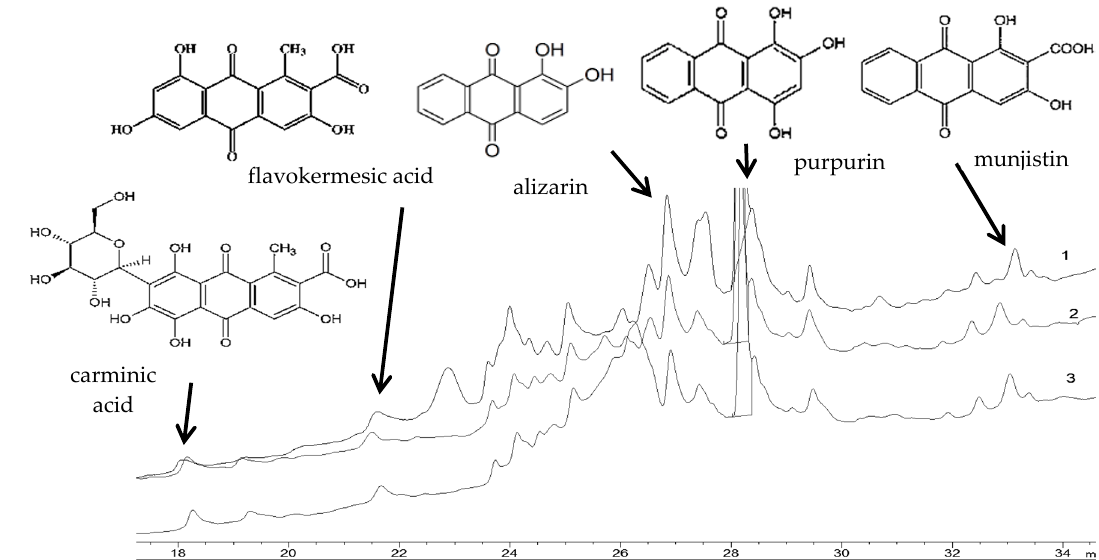
Figure 11. HPLC chromatograms of silk warps: 1- Sample 1 , from chasuble, 2- Sample 7 , from Fragment 2 as prior intervention, 3- Sample 3 from Velum.